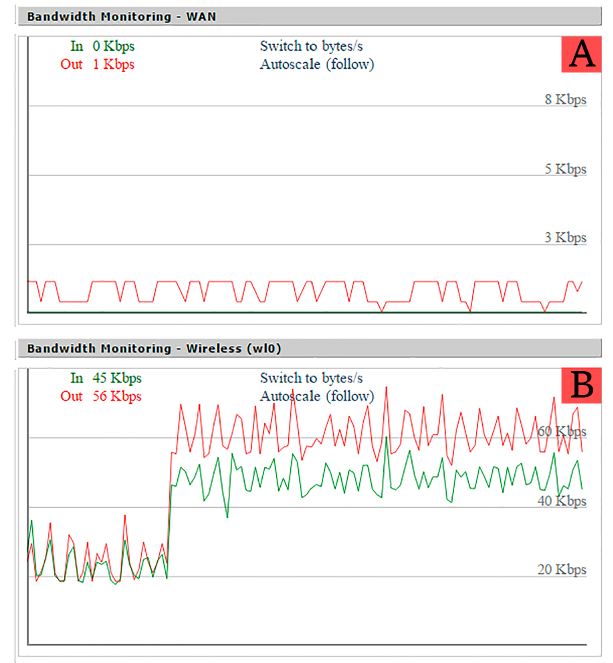
Figure 13. Access point load evolution during the test. ( A ) Load over wired interface; ( B ) Load over Wireless interface.